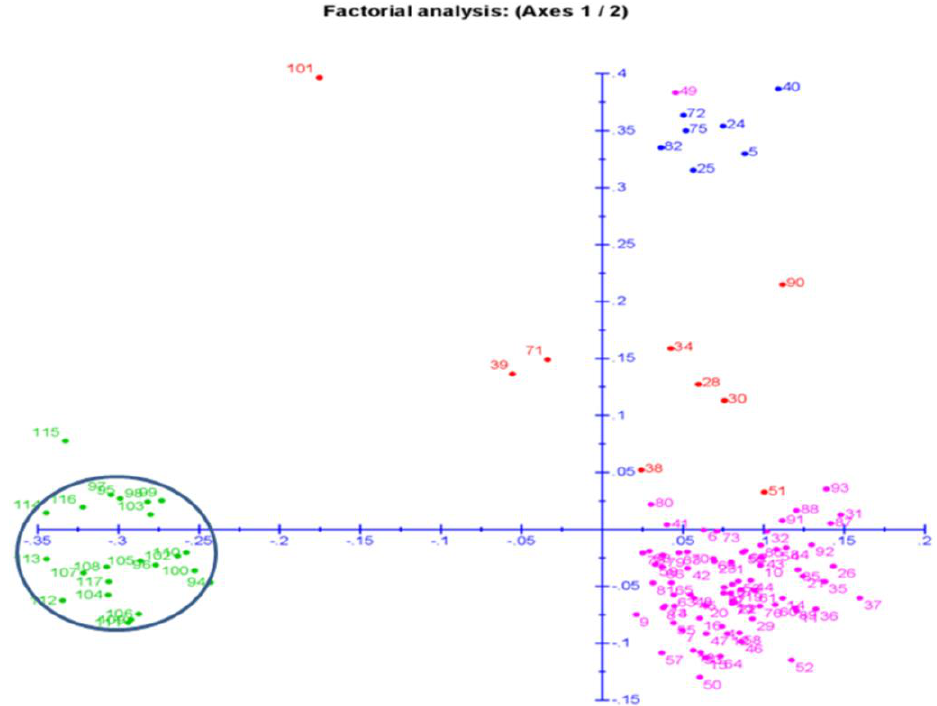
Figure 7. Distribution of 117 genotypes for the principal coordinate analysis (PCoA) based on 131 molecular markers’ genotyping for the six antioxidant traits. The dot numbers in the figure represent the serial number of the genotypes listed in Table 1. The numbers are colored on the basis of the subpopulations obtained from the structure analysis (SP1: pink; SP2: green; SP3: blue; Admix: red).